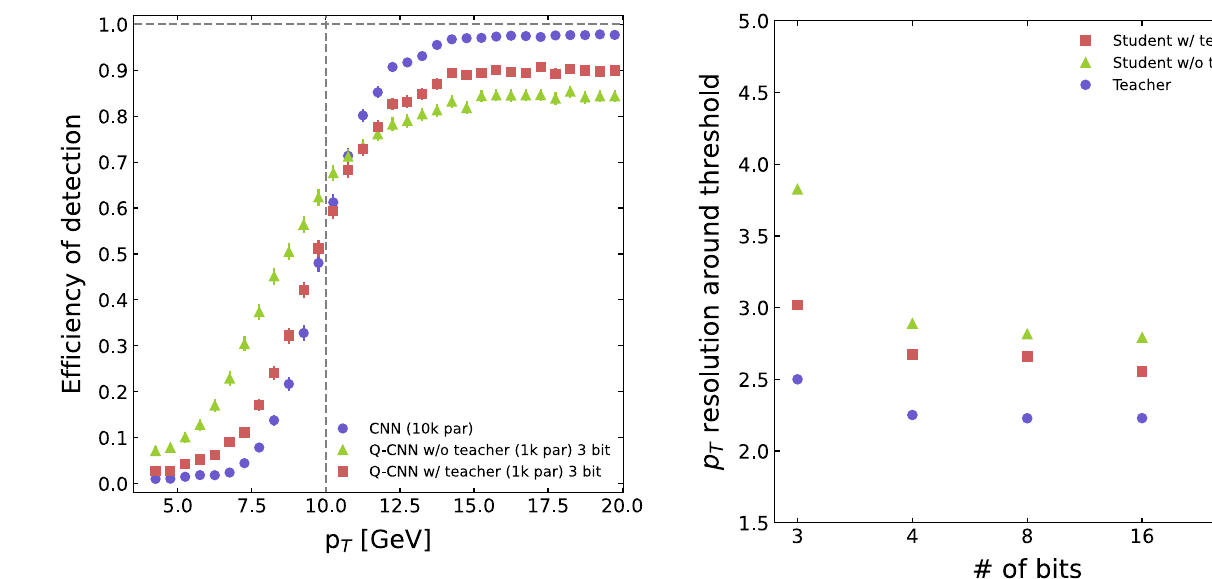
Fig. 10 Efficiency curves (realized as for Fig. 6). Statistical uncertain- ties computed as binomial confidence intervals are shown as well. If not visible, they’re smaller than the markers size. Here in indigo (cir- cles) the performance of the Teacher model. In light green (triangles) the performance of the Quantized Student (3 bits per weight) trained without any help from the Teacher. In red (squares) the performance of the Quantized Student (3 bits per weight) trained with hints from the Teacher